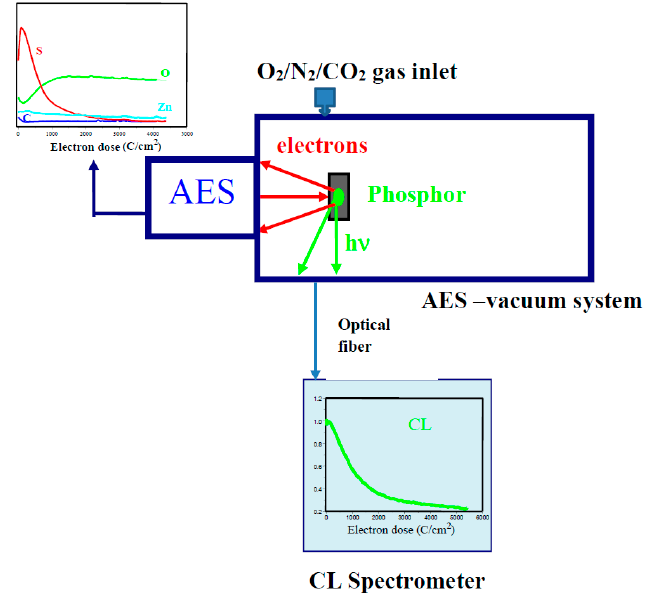
Figure 1. The CL/AES setup for electron degradation measurements.